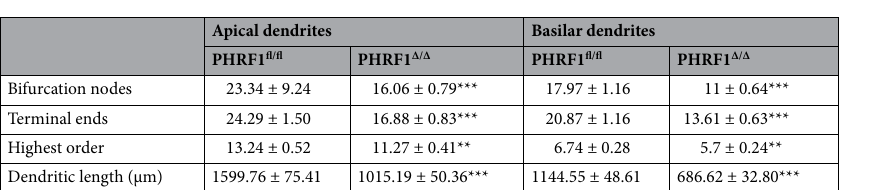
lengths of dendritic arbors. The total dendritic length was largely decreased in relation to the ablation of PHRF1 (Table 1). This might be attributed to the decrease of dendritic branches (Fig. 4c) and reduction of internodal segment length (Fig. 4d). These results indicated that the elongation and bifurcation of dendrites are affected